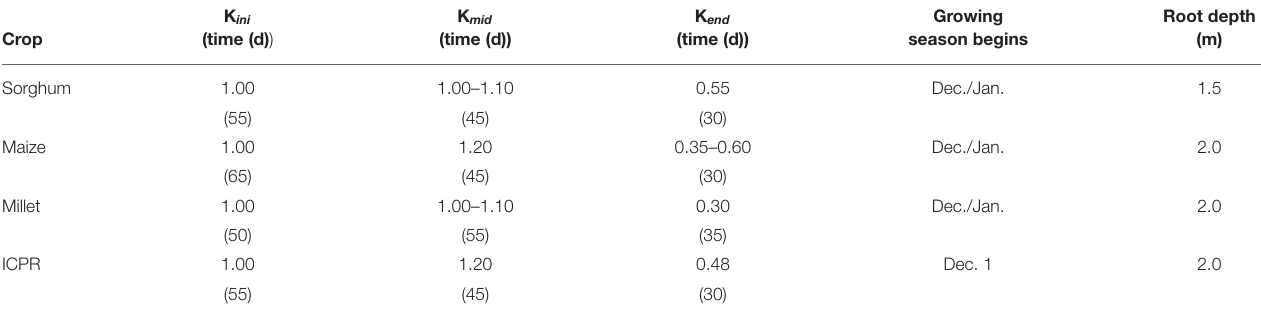
TABLE 1 | Crop coefficients and growing season in the Chididimo watershed.